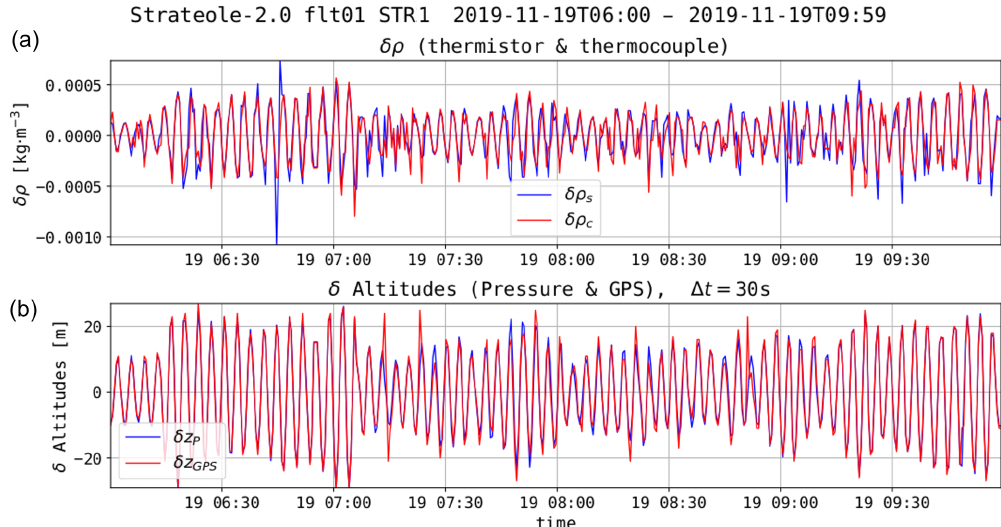
Figure 2. (a) Density fluctuations observed from 06:00 to 10:00UTC on 19 November. (b) Fluctuations in the height of the balloon for the same time interval.